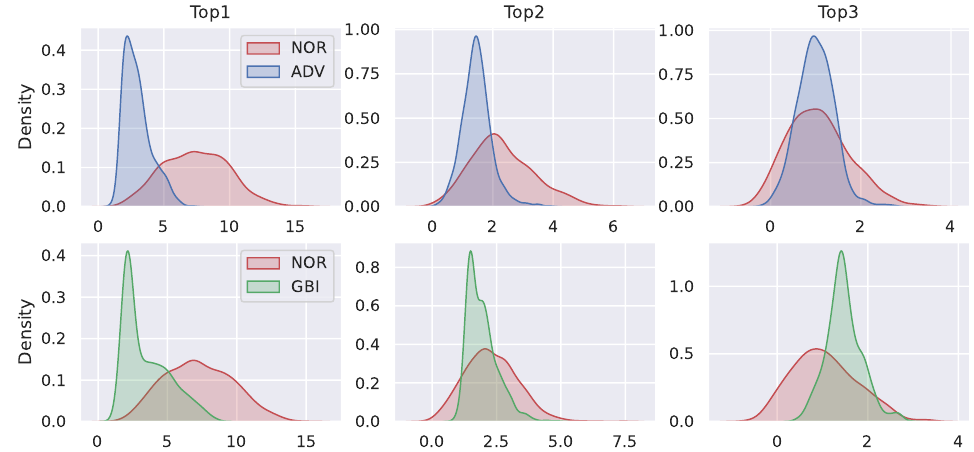
Figure 1. The difference of the distribution of model outputs between normal samples and adversarial examples (fake images).